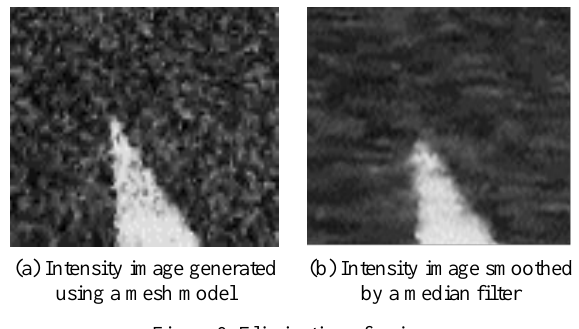
Figure 6. Detection of the nearest point using GPS time